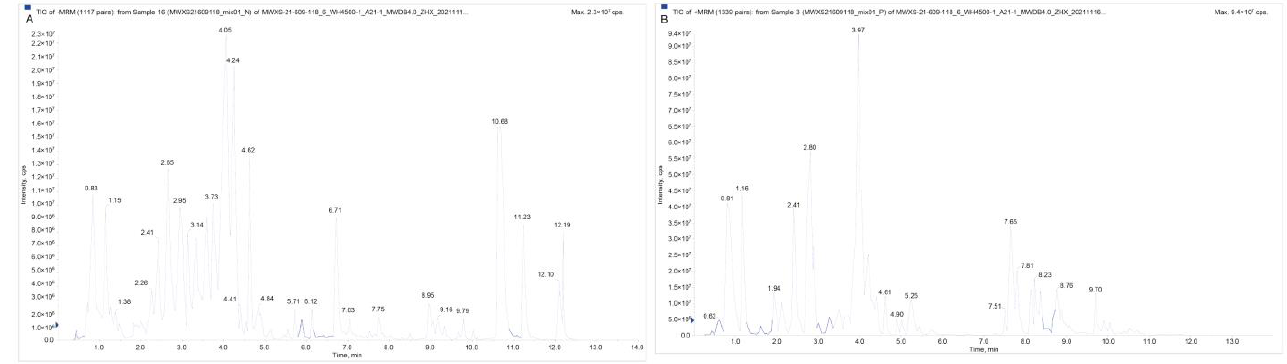
Figure 4. Total ion flow diagram for mixed sample mass spectrometry (( A ) QC-MS-TIC-N ( B ) QC- MS-TIC-P).